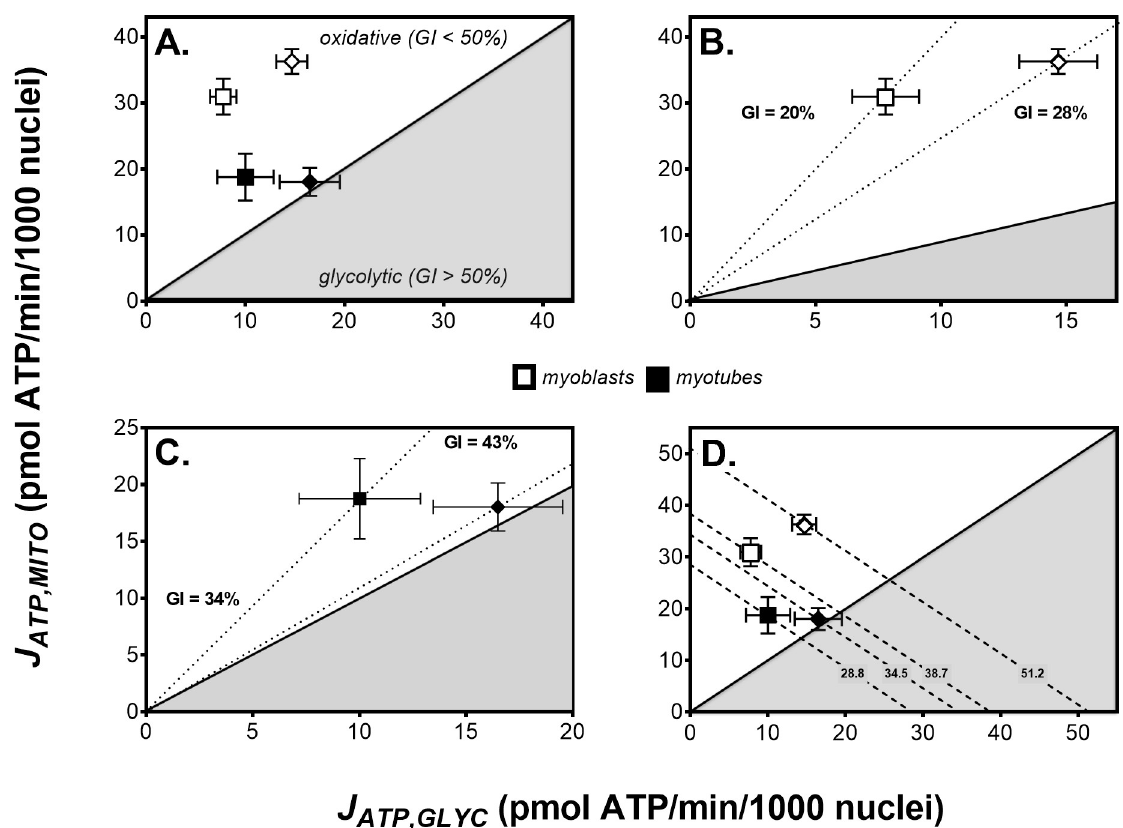
Fig 7. Nitrite increases the dependence of skeletal muscle cells on glycolytic ATP supply. Bioenergetic space plots [21] relate the rate of mitochondrial ATP supply ( J ATP , MITO ) to the rate of glycolytic ATP supply ( J ATP , GLYC ). Individual data obtained from experiments with static myoblasts and spontaneously contracting myotubes, in the absence (squares) or the presence (diamonds) of NaNO 2 (0.75 and 5 μ M for myoblasts and myotubes, respectively), were sourced from Fig 5. Data are means ± SEM of 12–19 well measurements sampled from 4–5 independent XF assays. Diagonal lines with positive slopes reflect the glycolytic index (GI), i.e., the percentage of total ATP synthesis from glycolysis. The white area above the GI 50% diagonal covers ‘oxidative’ bioenergetic space, whereas the grey shaded area below this diagonal covers the ‘glycolytic’ space. GI values indicated by the dotted lines in Panels B and C were calculated from the shown mean rates of oxidative and glycolytic ATP supply. The dashed diagonal lines with a slope of –1 in Panel D indicate space with the same total rate of ATP supply. The numbers labelling these lines are mean supply rates in pmol ATP/min/1000 nuclei.